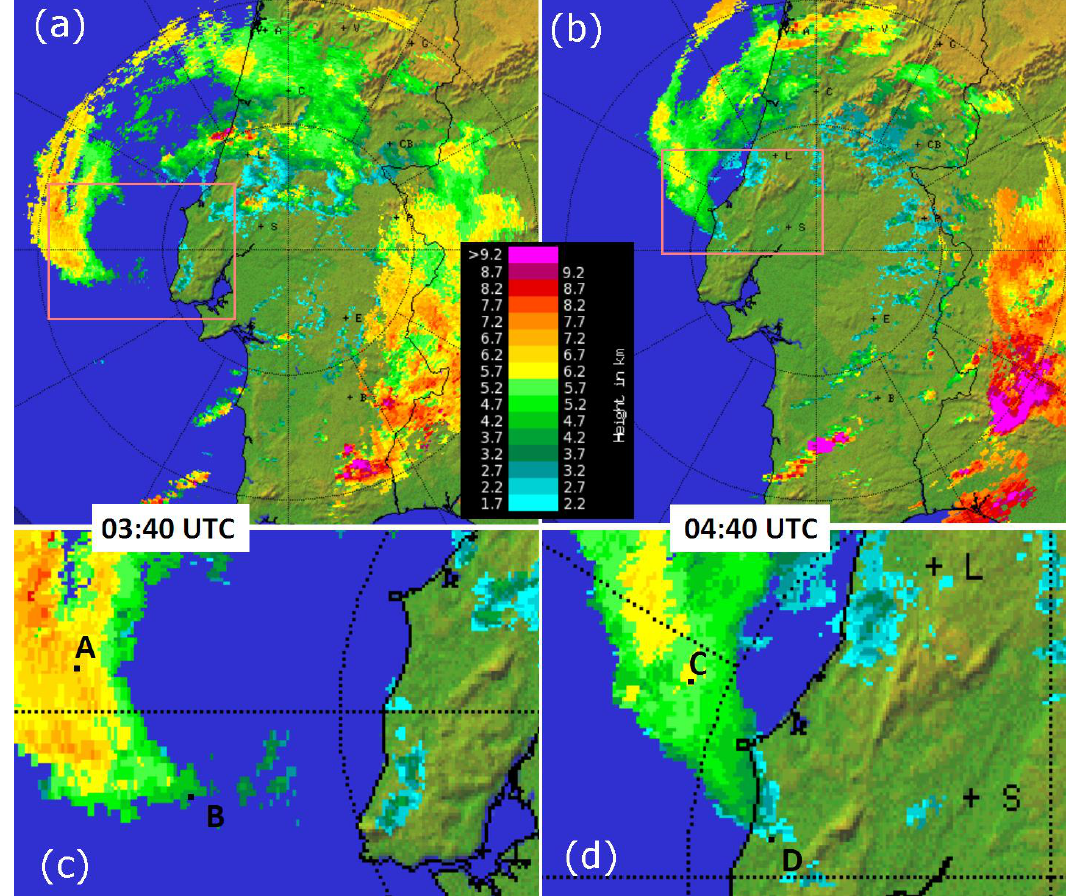
Figure 11. Echo tops (km) from CL radar at ( a ) 03:40 UTC and ( b ) 04:40 UTC, on 23 December 2009; ( c ) and ( d ) are zoomed-in images represented in ( a ) and ( b ), respectively. “A” and “C” represent points located 50 km upwind of the tip, and “B” and “D” represent points located at the edge of the cloud head tip.